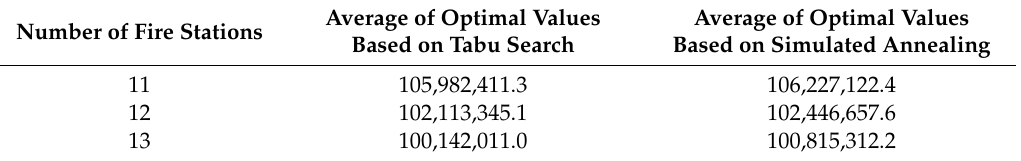
Table 17. Average of optimal values for 10 iterations of the model using both algorithms.